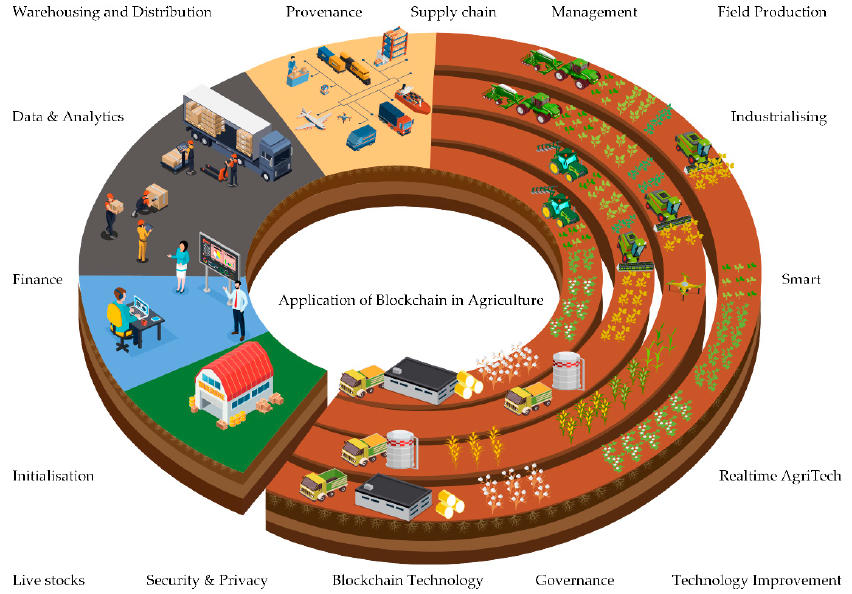
Figure 6. Application of blockchain in various verticals of the agriculture domain.